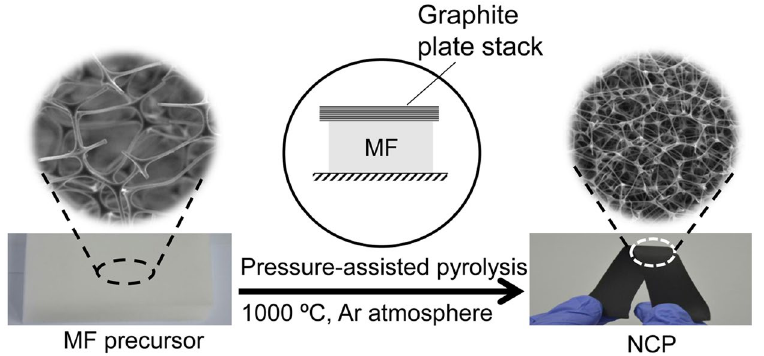
Figure 1. Schematic of the fabrication process of